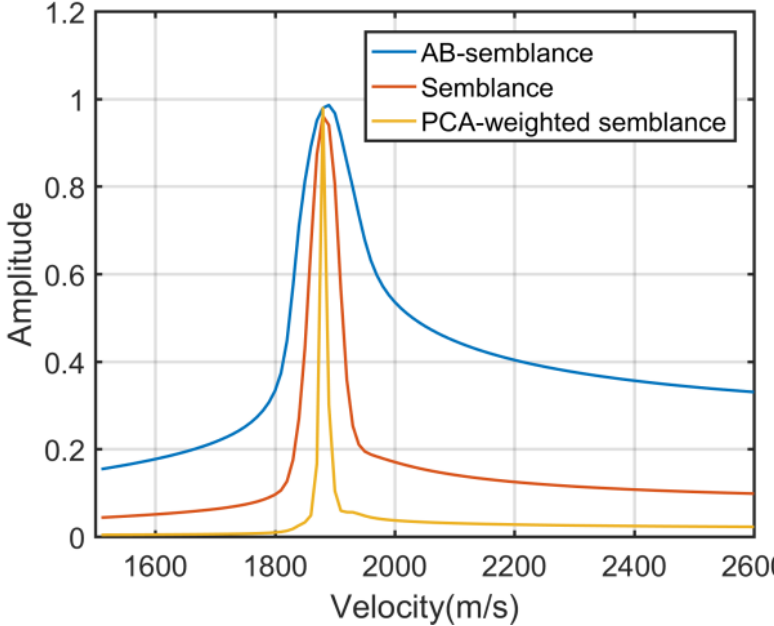
Figure 3. Comparison of the semblances of different methods at time 0.24 s. Where the blue curve represents the AB-semblance, the red curve represents the conventional semblance, and the yellow curve represents the proposed PCA-weighted semblance.